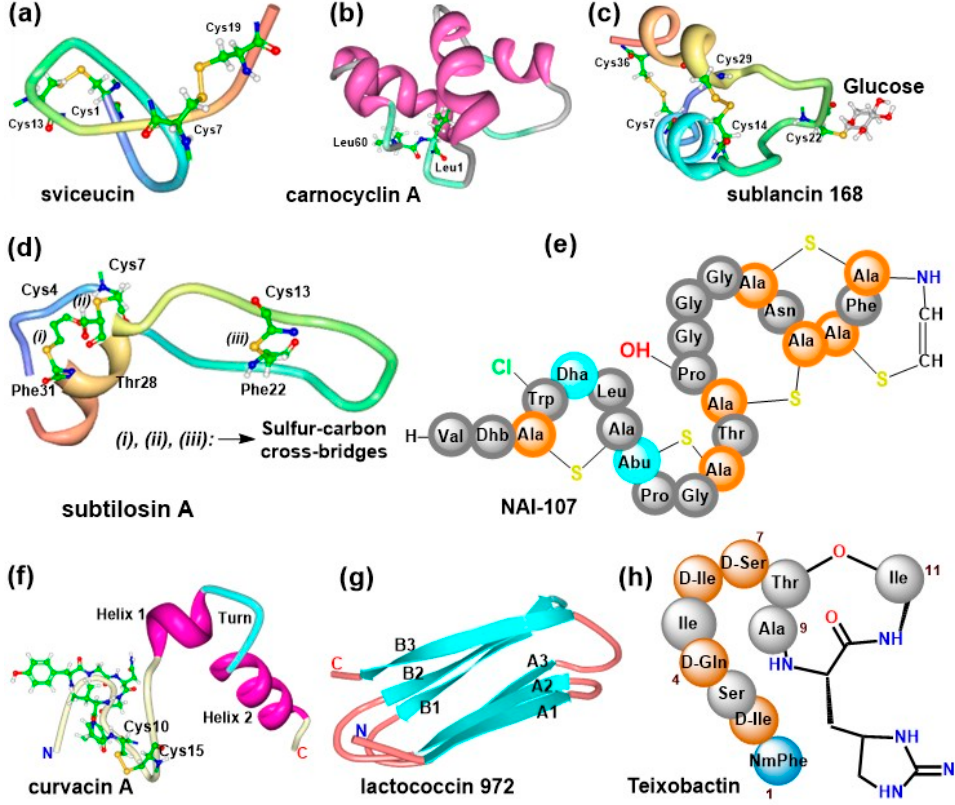
Figure 4. Structure of selected peptides from bacterial sources. ( a ) Lasso peptides sviceucin, showing two intramolecular disulfide bridges. ( b ) Circular peptide carnocyclin A, showing N- to C-terminal peptidyl linkage between Leu1 and Leu60. ( c ) Glycocin peptide sublancin 168, showing a glucose moiety linked to Cys22 and two intramolecular disulfide bridges. ( d ) Sactipeptides subtilosin A, showing the coordination of the sulfur- α -carbon bridges. ( e ) NAI-107 has 5 intramolecular thioether cross-linkages, additional 5-chloro-trypthopan, mono-/bis-hydroxylated proline and a c-terminal aminovinylcysteine. ( f ) Pediocin-like curvacin A, showing the N-terminal YGNGVXC conserved motif, the N-terminal intramolecular disulfide bridge between to Cys10 and Cys15, and the distinct C-terminal helical region. ( g ) Non-pediocin-like single-peptide lactococcin 972. ( h ) Non-ribosomally synthesized peptide teixobactin compose of four D-amino acids, enduracididine and an N-terminal methylphenylalanine. Structures were edited with protein workshop using the solution NMR structural data for each molecule.